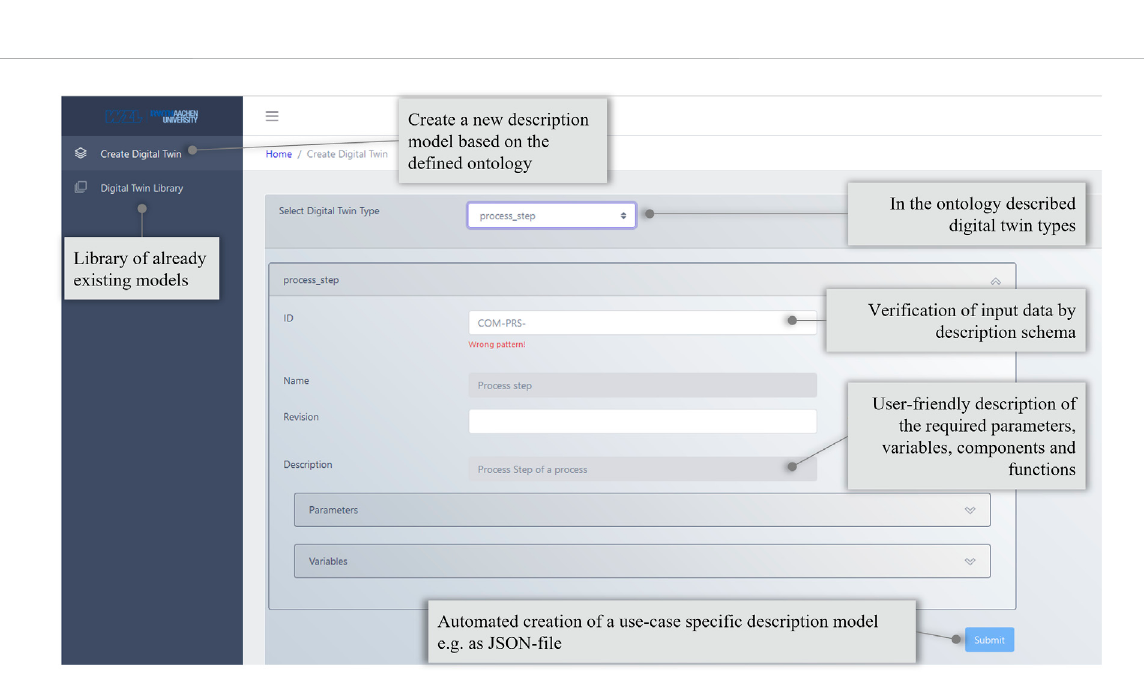
Frontiers in Mechanical